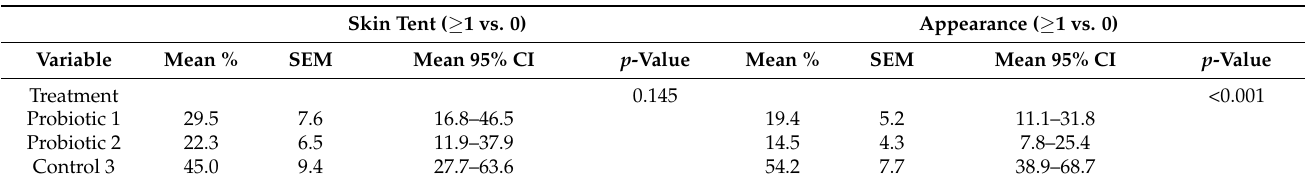
Table 8. Skin tent and appearance scores modeled as dichotomous outcomes estimated from multi- variable models a among dairy calves supplemented with two probiotic products to reduce Clostridium perfringens